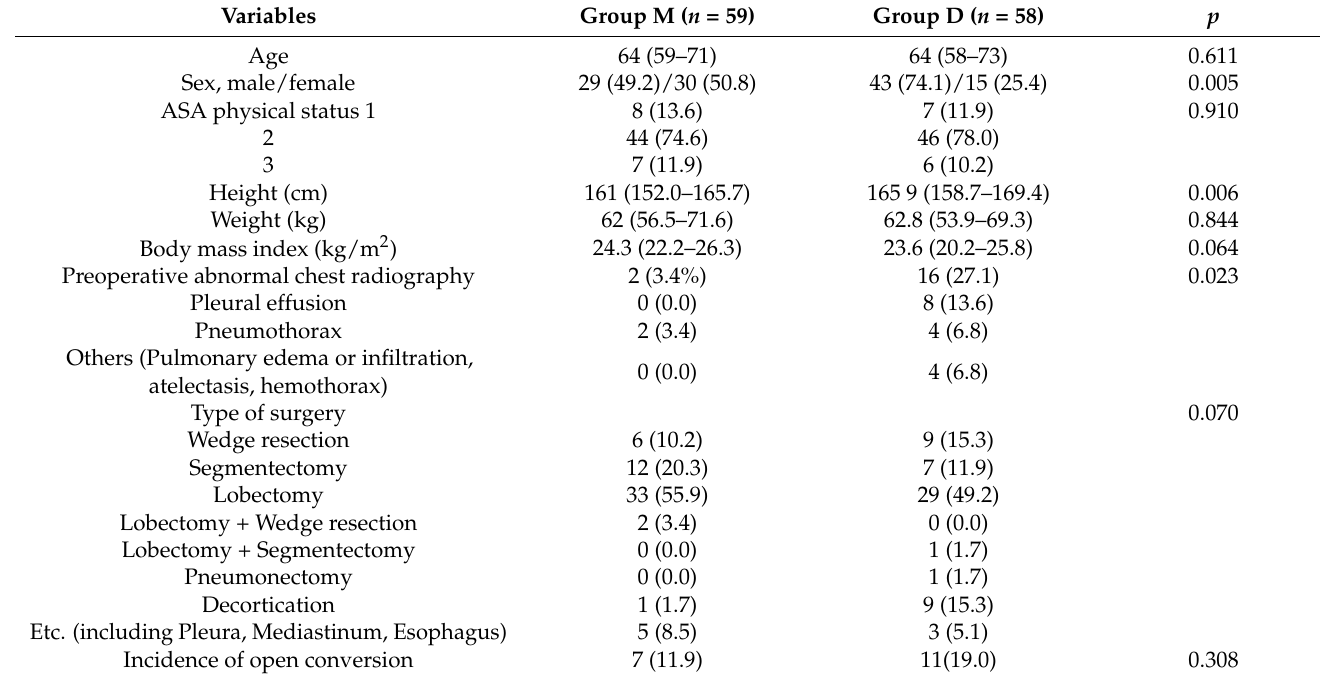
Table 1. Demographics and surgical data.